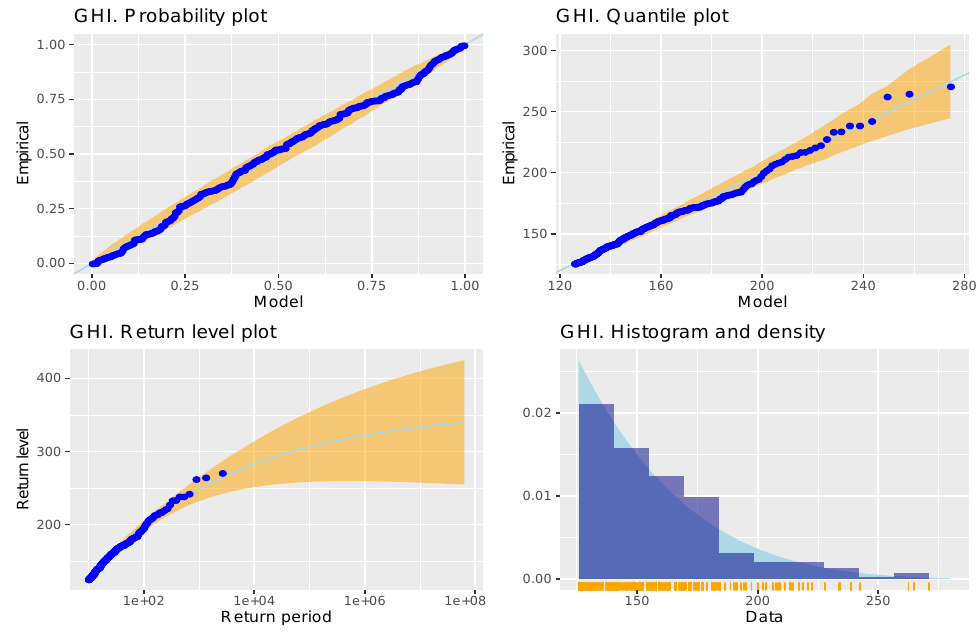
Figure 5. Marginal diagnostic plots for GHI. Multivariate conditional Spearman’s ρ correlation plots are shown in Figure 6, where ρ is Spearman’s coefficient of correlation. Figure 6 shows a very weak and positive correlation between temperature and GHI, whereas RH and GHI are negatively